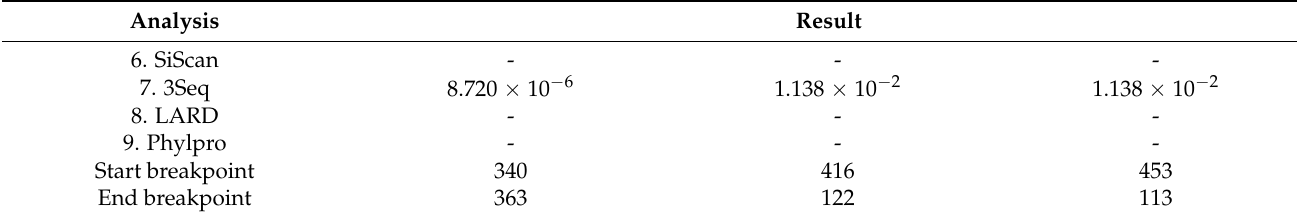
comparison of the putative tribal characters of